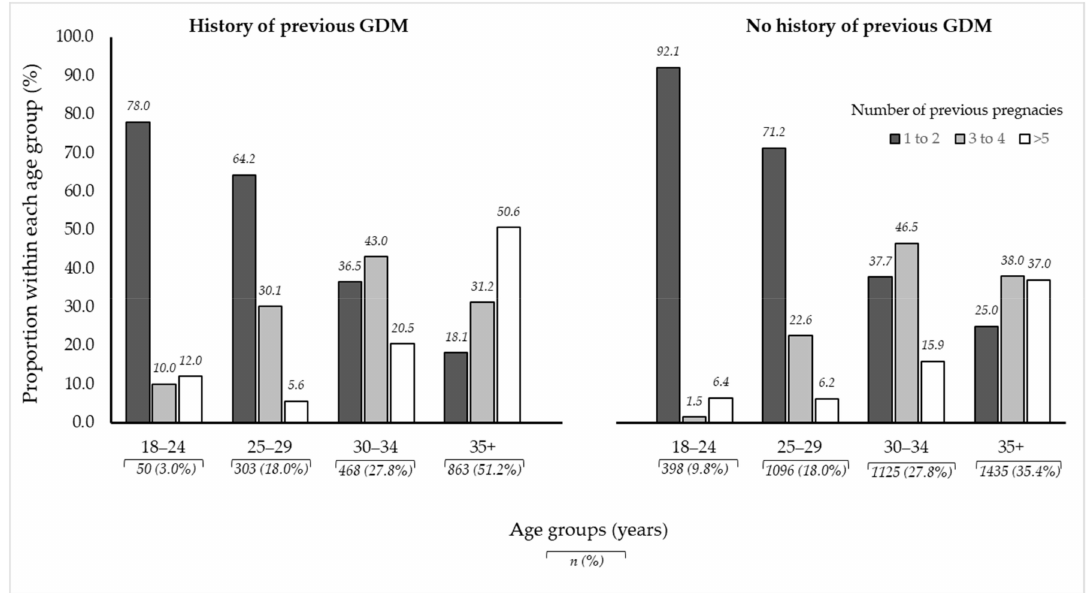
Figure 1. Illustration of age and gravidity proportions between women with a history of previous GDM and those with no history of previous GDM amongst 5738 pregnant women in Al Ain, UAE. The Mutaba’ah Study.